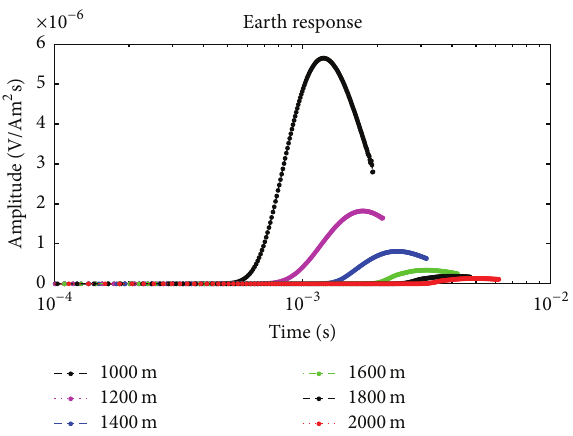
Figure 10: MTEM earth response at different